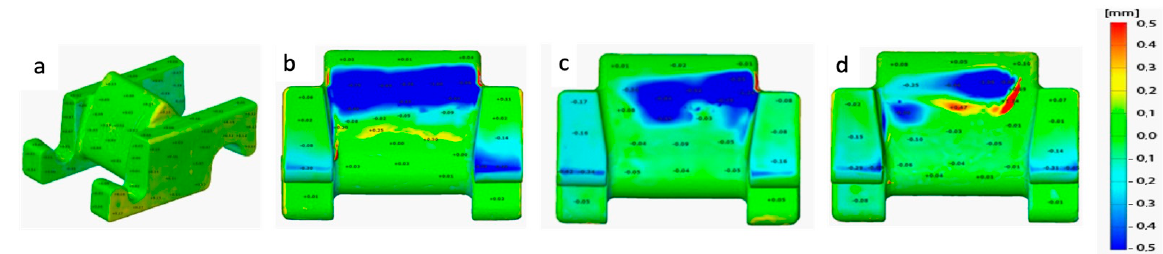
Figure 15. Test results of toothed segments: ( a ) toothed segments before the test; ( b ) uniform wear; ( c ) one-sided wear; ( d ) intensive one-sided wear.